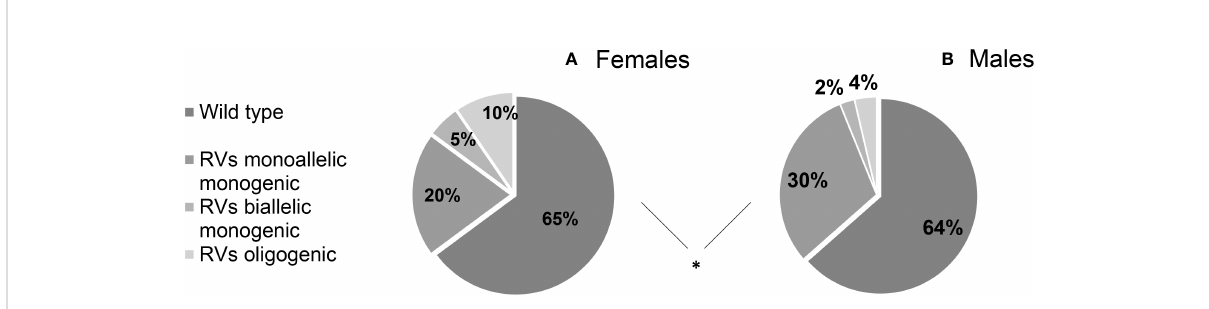
FIGURE 2 Prevalence of rare genetic variants in female (A) and male (B) cohort of patients according to their genetic assortment. RVs, rare genetic variants. Comparison between male and female patients using Fisher ’ s exact test: * P =